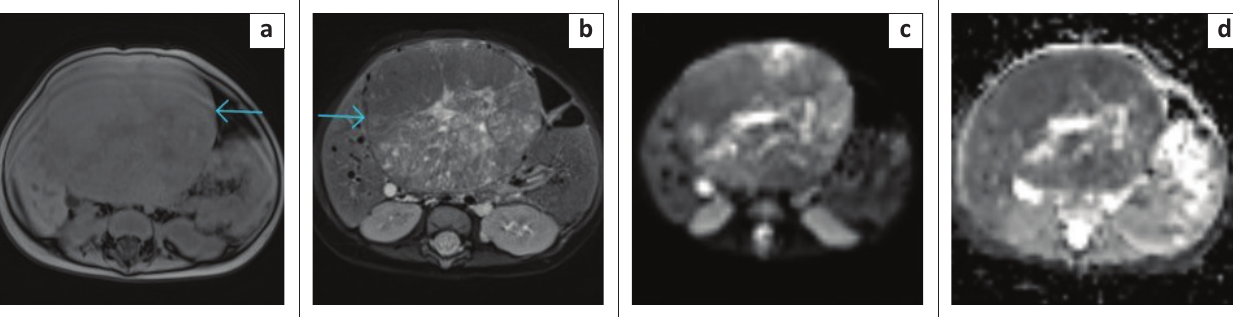
FIGURE 6: (a & b)T1W and T2W axial images illustrate a large heterogenous T1W hypointense, T2W hyperintense round hepatic mass (blue arrows) replacing the left liver lobe. The mass demonstrates areas of mild restricted diffusion on DWI and ADC sequences (c & d).